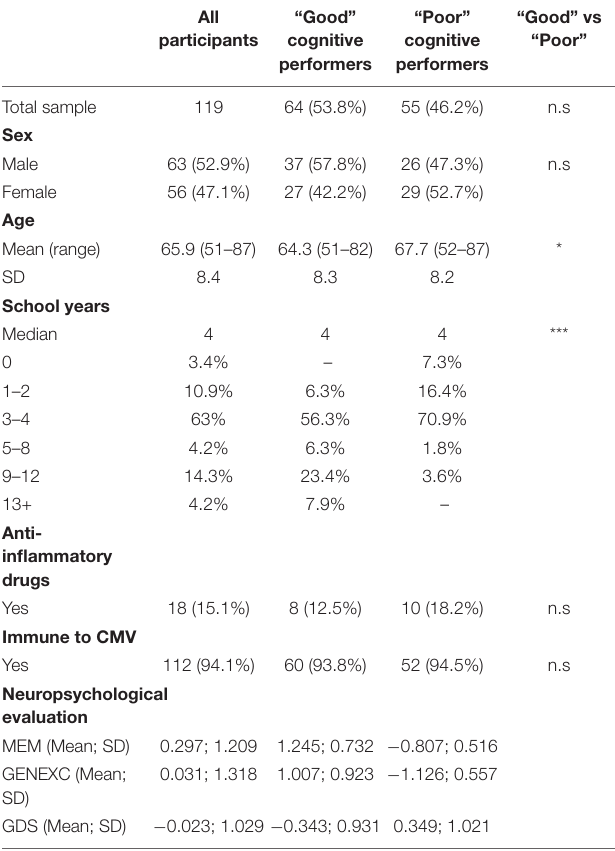
TABLE 1 | Socio-demographic, clinical, and neuropsychological